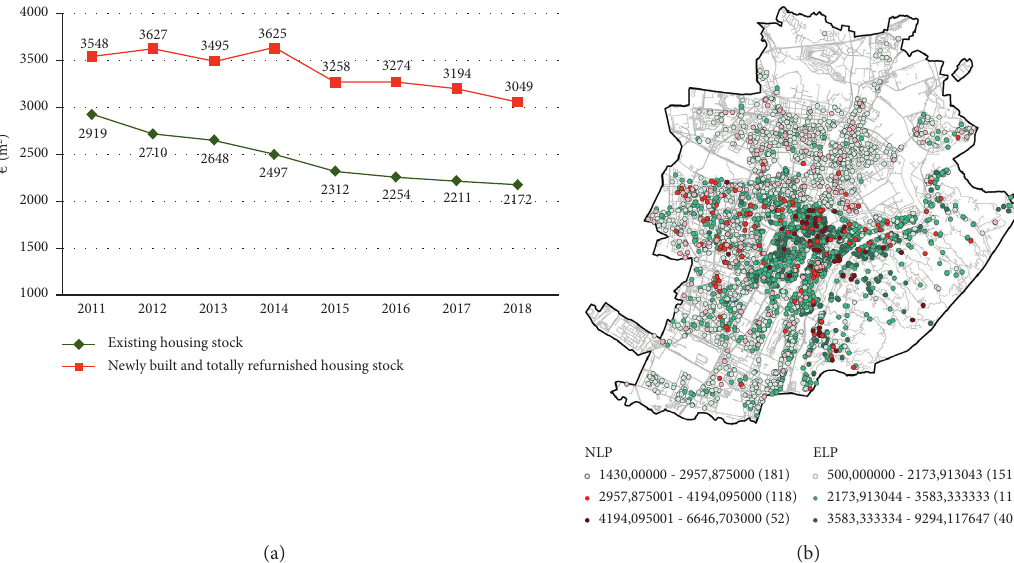
Figure 2: Existing housing stock and newly built and totally refurbished housing stock: listing prices mean temporal trend 2011–2018 (a); listing prices mean spatial distribution (b) (source: authors’ elaboration on TREMO